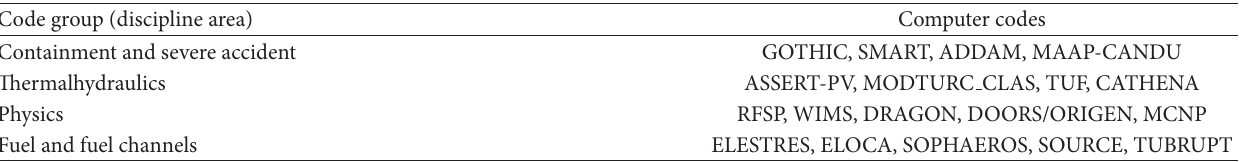
Table 1: List of COG IST codes in four